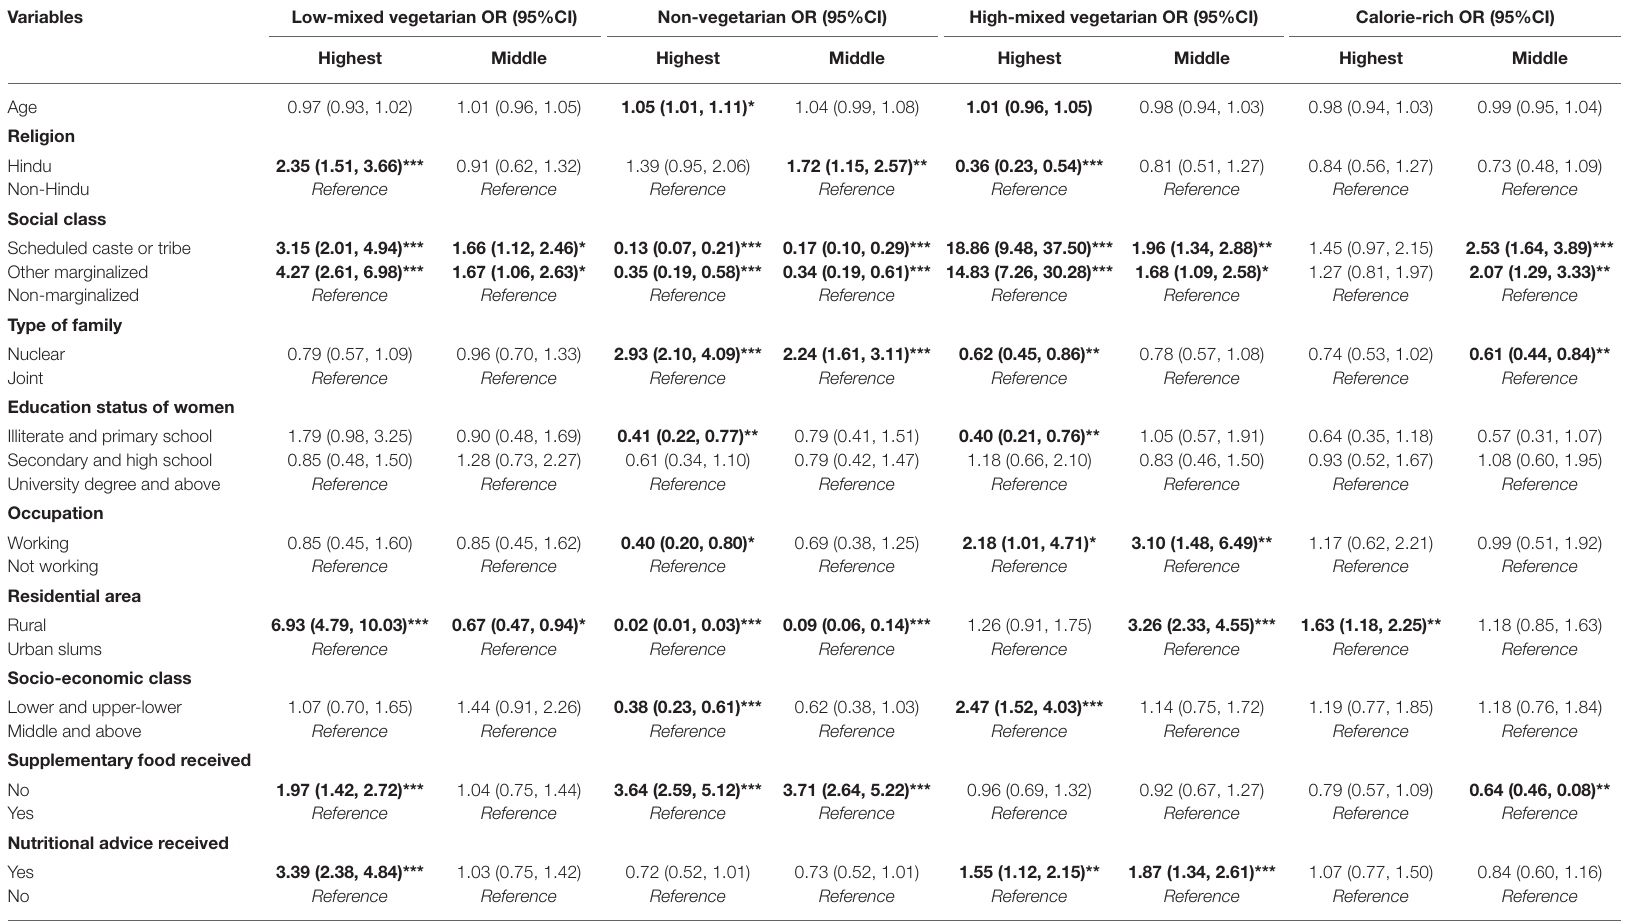
TABLE 3 | Unadjusted multinomial logistic regression for the dietary patterns’ associations with socio-demographic variables and access to nutrition services among women ( n = 922). Variables Low-mixed vegetarian OR (95%CI) Non-vegetarian OR (95%CI) Calorie-rich OR (95%CI) Highest Middle Highest Middle Highest Middle Highest